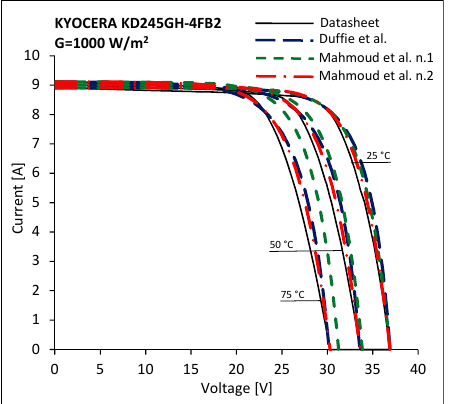
Figure 13. Comparison between the issued I-V characteristics of the Kyocera KD245GH-4FB2 at G = 1000 W/m 2 and the characteristics calculated by means of the Duffie et al. and the Mahmoud et al. models.